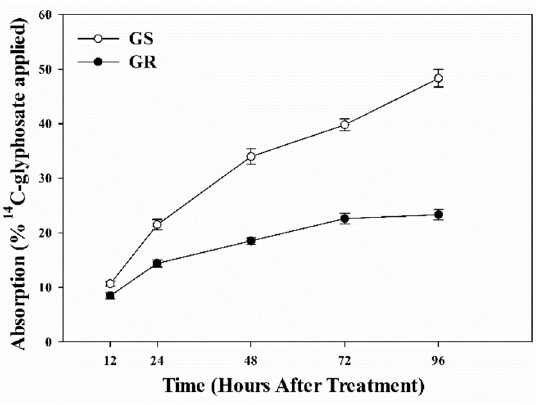
Figure 3. Absorption of glyphosate in susceptible (GS) and resistant (GR) populations of C. distichophylla . Symbols denoted are the ( n = 5) standard errors of the mean.